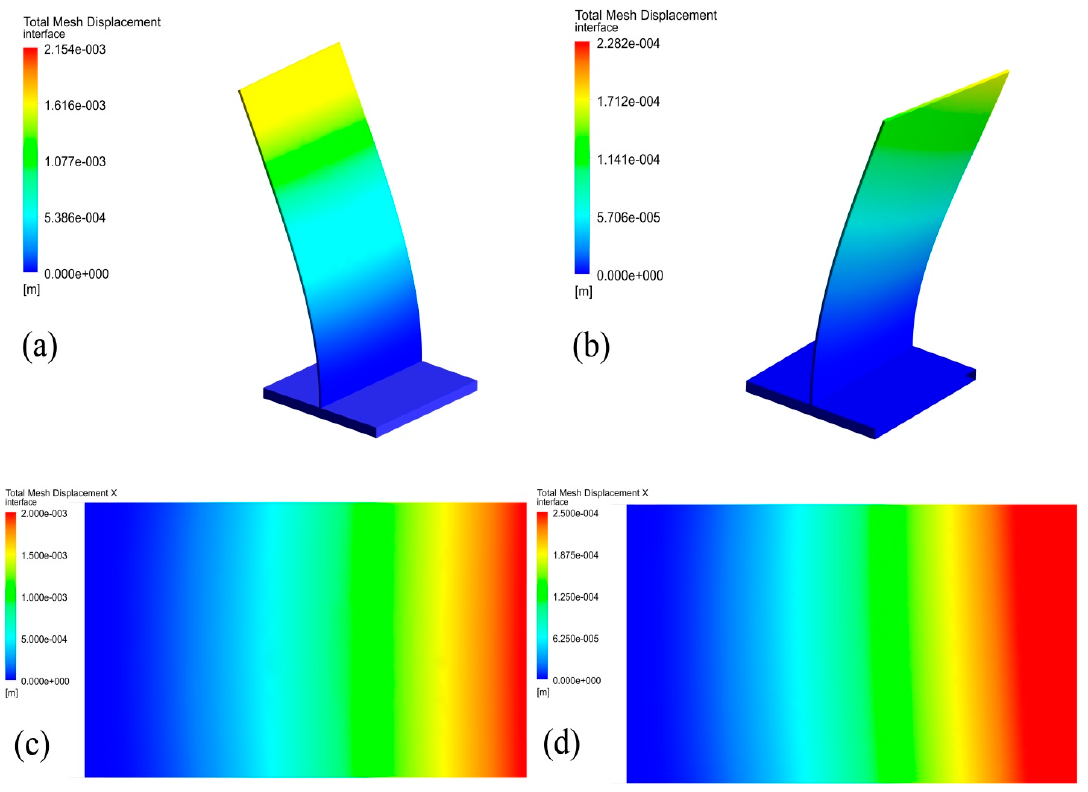
Table 4. Difference between vibrational and natural frequency.